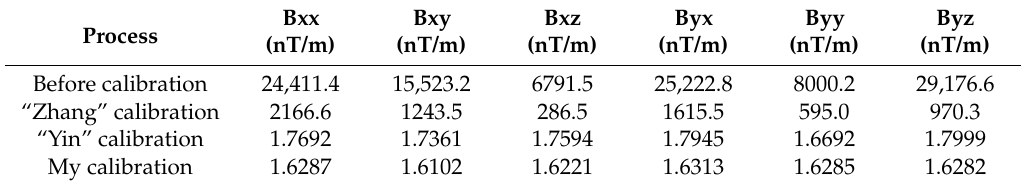
Table 2. Comparison of RMSE of tensor components before and after calibration using the simulation.